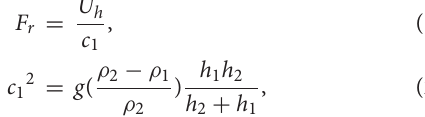
( Table 1 ), indicating a near-inertial ocean surface. Because our observations were made at different positions relative to the three TCs, we investigated velocity variations during TCs Bailu, Lingling, and Mitag. The modeled velocities from Exp. 1 are shown in Figure 3 . During TC Bailu, the velocity (0.15 m/s) was much smaller than velocities during the other two TCs. The period of near-inertial oscillation is described by f eff = ε/ 2 + f , where ε is the relative velocity and f is the local inertial